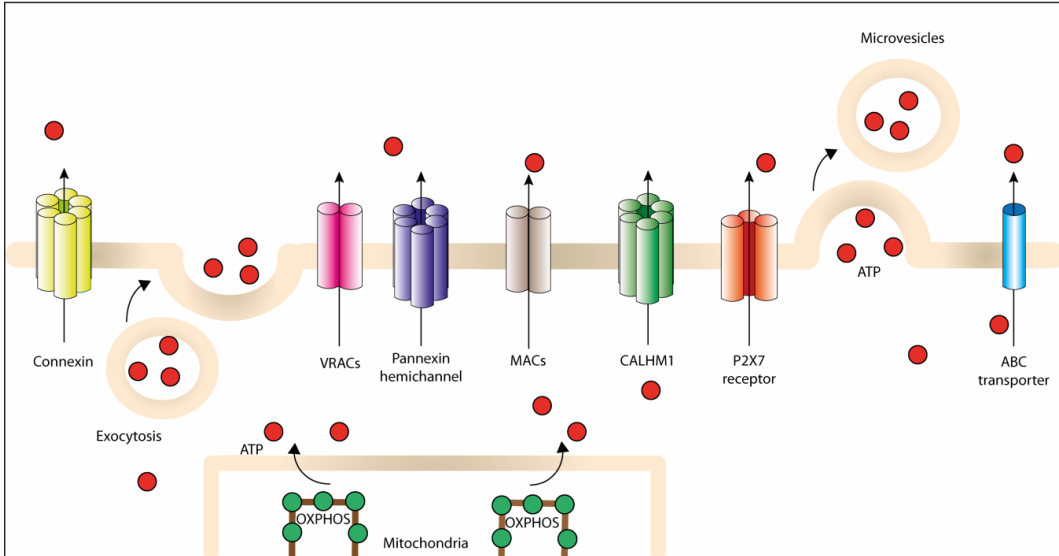
Figure 1. Di ff erent pathways for regulated ATP release into the tumor microenvironment (TME). ATP generated inside the cell can be actively released through plasma membrane-derived microvesicles, vesicular exocytosis or di ff erent non-exocytotic conductive pathways, including specific ATP-binding cassette (ABC) transporters, the P2X7R, connexin and pannexin channels, calcium homeostasis modulator 1 (CALHM1) channel, volume-regulated ion channels (VRACs) and maxi-anion channels